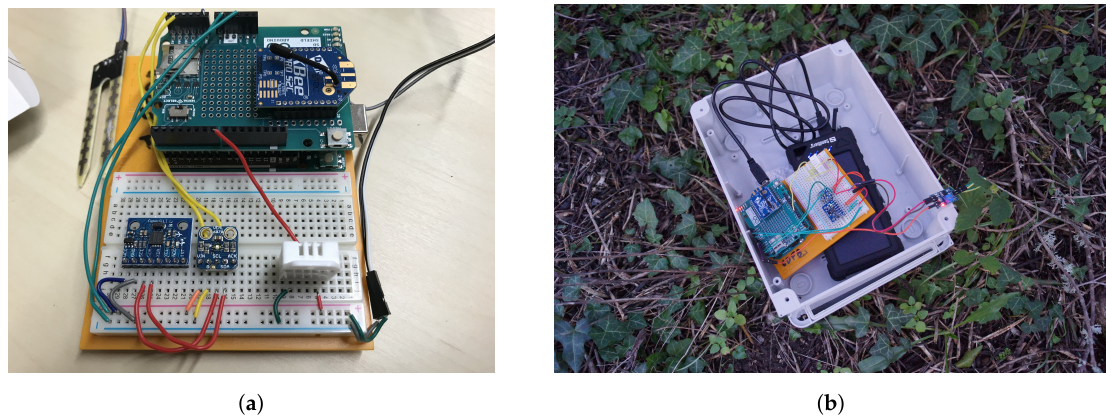
Figure 1. Fully assembled Arduino Uno nodes: ( a ) a node with all accompanying sensors; and ( b ) a node operating within the protective